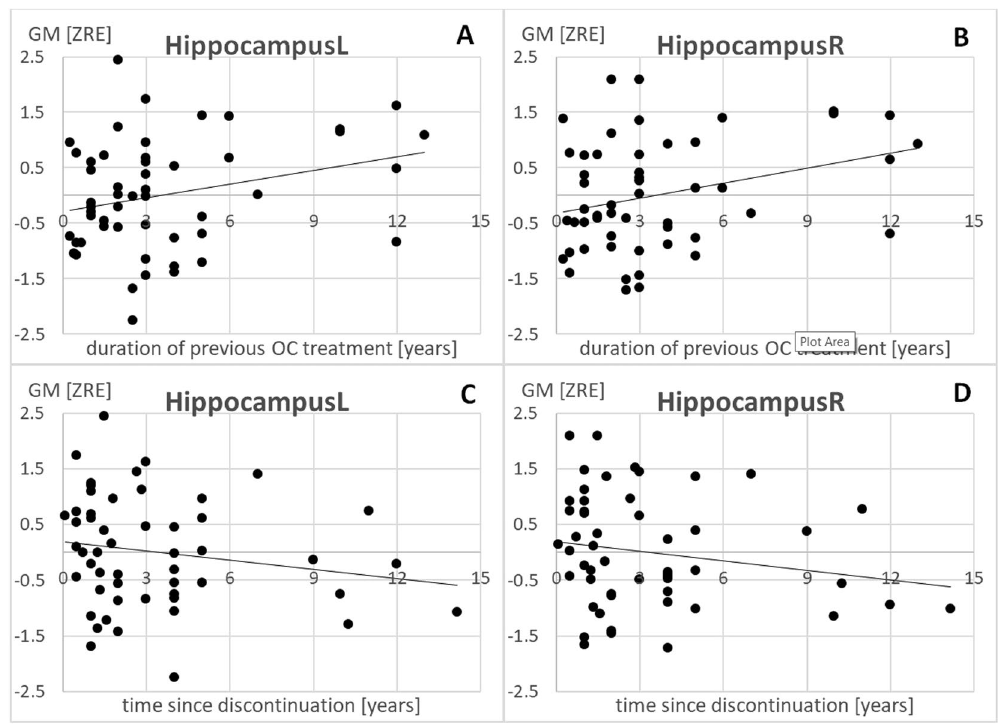
Figure 1. Relationship of previous OC treatment duration and time since discontinuation to gray matter volumes in the left and right hippocampus. L = left, R = right, ZRE = standardized residual after controlling for age and total intracranial volume.